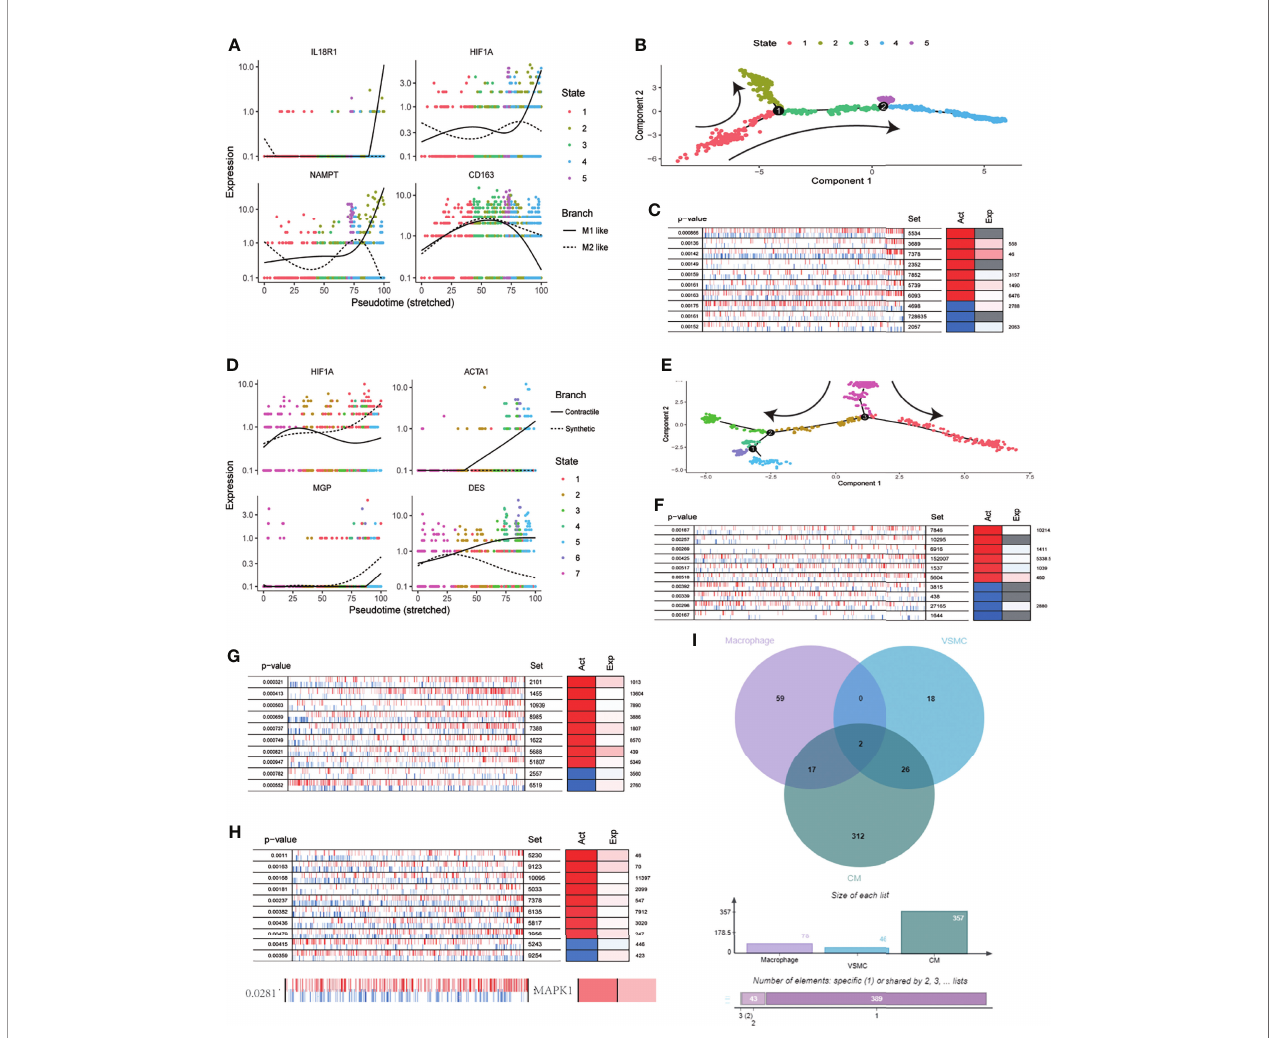
FIGURE 5 | MEK signaling pathway was involved in the regulation of HIF-1A on cell function. (A) Expression distribution of IL18R1,HIF1A,CD163 and NAMPT on pseudo time locus in macrophages. The solid line represents M1 polarization direction, and the dotted line represents M2 polarization direction. (B) Pseudo-time locus analysis of polarization of macrophages (C) Top 10 proteins activation states derived from VIPER algorithm based on HIF-1 signaling pathway scores in macrophages. (D) Expression distribution of HIF1A, ACTA1, MGP and DES on pseudo time locus in VSMC. The solid line represents contractile direction, and the dotted line represents synthetic direction. (E) Pseudo-time locus analysis of phenotypic transformation in VSMC. (F) Top 10 proteins activation states derived from VIPER algorithm based on HIF-1 signaling pathway scores in VSMC. (G) Top 10 proteins activation states derived from VIPER algorithm based on HIF-1 signaling pathway scores in CM. (H) Top 10 proteins and MAPK1 activation states derived from VIPER algorithm based on HIF-1 signaling pathway scores in EC. (I) Venn diagram of activated proteins based on VIPER algorithm (macrophages, VSMC and CM). The two proteins obtained from intersection were MAP2K1 and